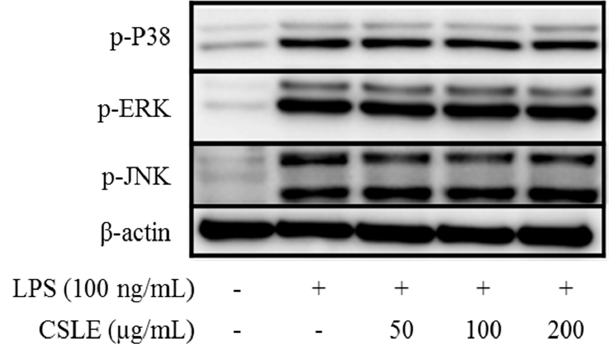
Figure 6. MyD88-dependent pathway associated protein expression in LPS-stimulated RAW 264.7 macrophages. Cells were pretreated with CSLE (0.05, 0.1, and 0.2 mg/mL) for 1 h before exposure to LPS (100 ng/mL) for 15 min. MAPK (p38, ERK1/2, and JNK) phosphorylation was detected using a western blot analysis.